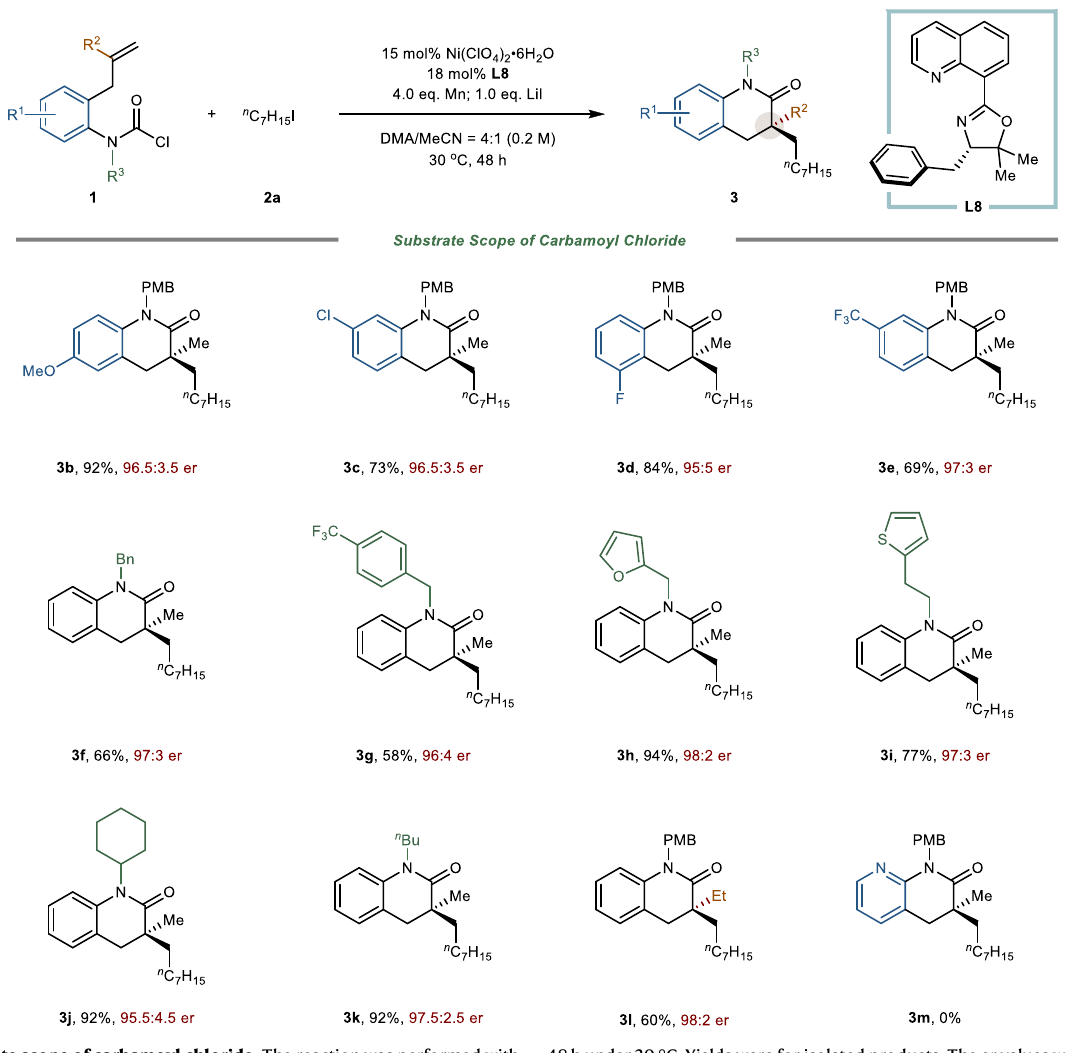
Fig. 3 | Substrate scope ofcarbamoyl chloride. The reaction wasperformed with carbamoylchloride 1 (1.0eq.),iodoheptane 2a (3.0eq.),Ni(ClO 4 ) 2 (cid:129) 6H 2 O (15mol%), L8 (18mol%), Mn (4.0 eq.), LiI (1.0 eq.), DMA/MeCN (v/v=4/1, 0.2M), stirred